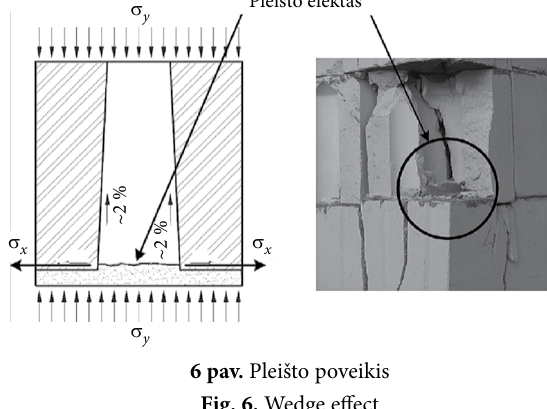
Fig. 6. Wedge effect